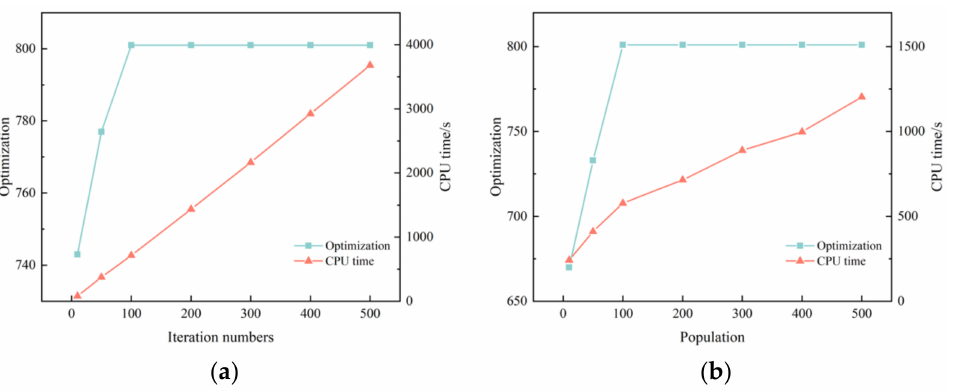
Figure 2. ( a ) Optimization and CPU time under different iteration numbers; ( b ) Optimization and CPU time under different